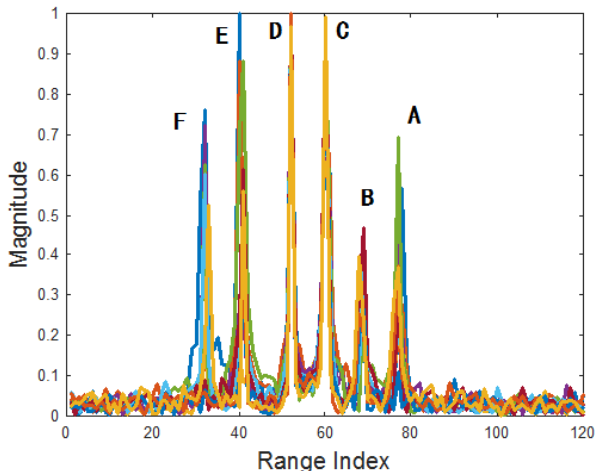
Figure 6a, where most energy falls on the first three largest ones, and the smaller SVs only contain the noise. Figure 6b–d give the RSVs corresponding to the 1st, 2nd, 3rd largest SVs. It can be seen that the 1st RSV is consisted by the most stable components of the HRRP sequence, thus the scatterer C and D have more energy in it. The 2nd singular value contains more fluctuate components where scatterer F , E , B and A are more prominent than C and D . As to the 3rd singular value, C and D are even weaker than the others, nearly submerged by the noise.